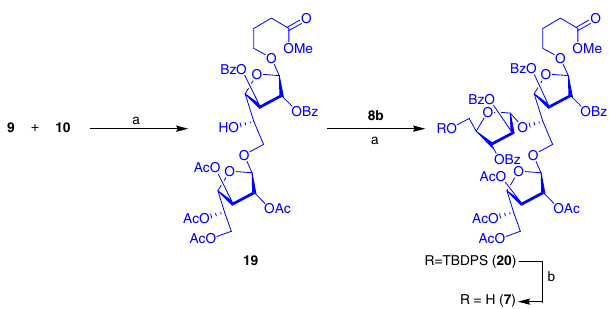
Figure 5 | Synthesis of cassette D. Reagents and conditions: (a) AuCl 3 (7mol%), AgOTf (7mol%), CH 2 Cl 2 , 4Å MS powder, 25 (cid:2) C, 2h; 70% for 19 and 75% for 20 . (b) Py (cid:2) HF, THF:Py (5:1), 0 (cid:2) C - 25 (cid:2) C, 4h, 95%.